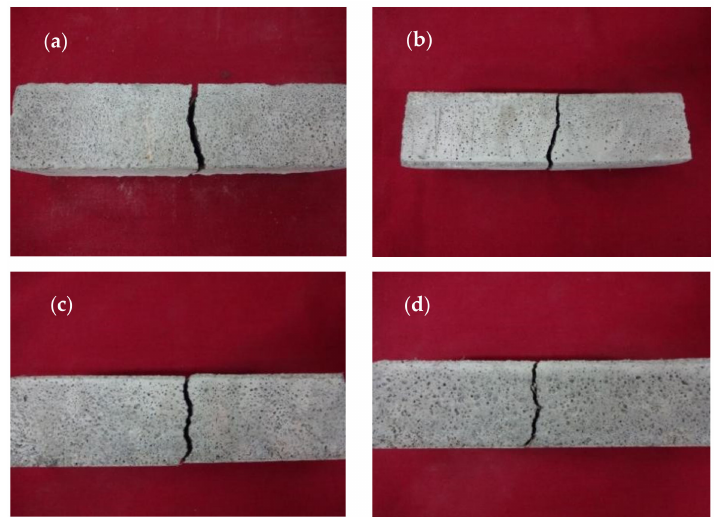
Figure 12. The crack pattern of the control mortar bending test sample ( a ), the addition of 1% ( b ), 2% ( c ), and 3% ( d ) EFB hydrochar.